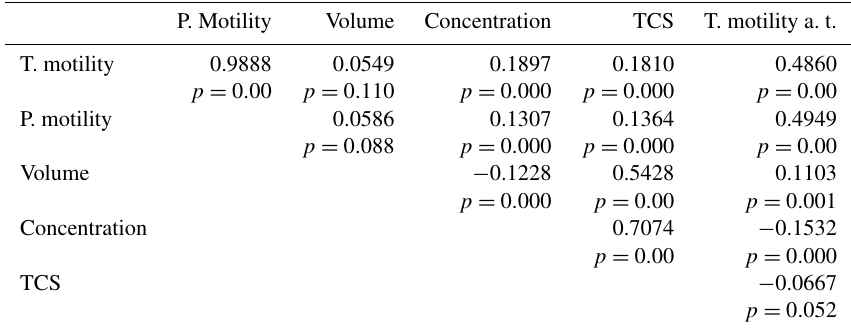
Table 5. Pearson correlation coefficients among dependent variables with p